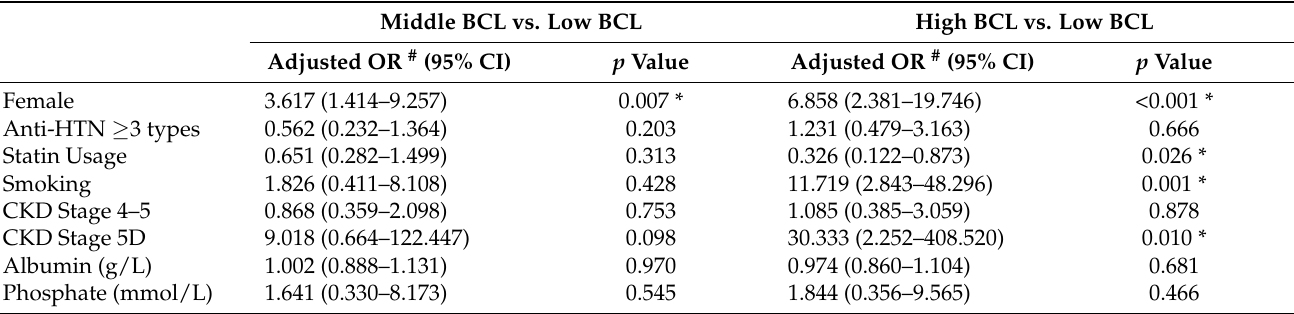
Table 3. Multinomial Logistic Regression Analysis of BCL Associated